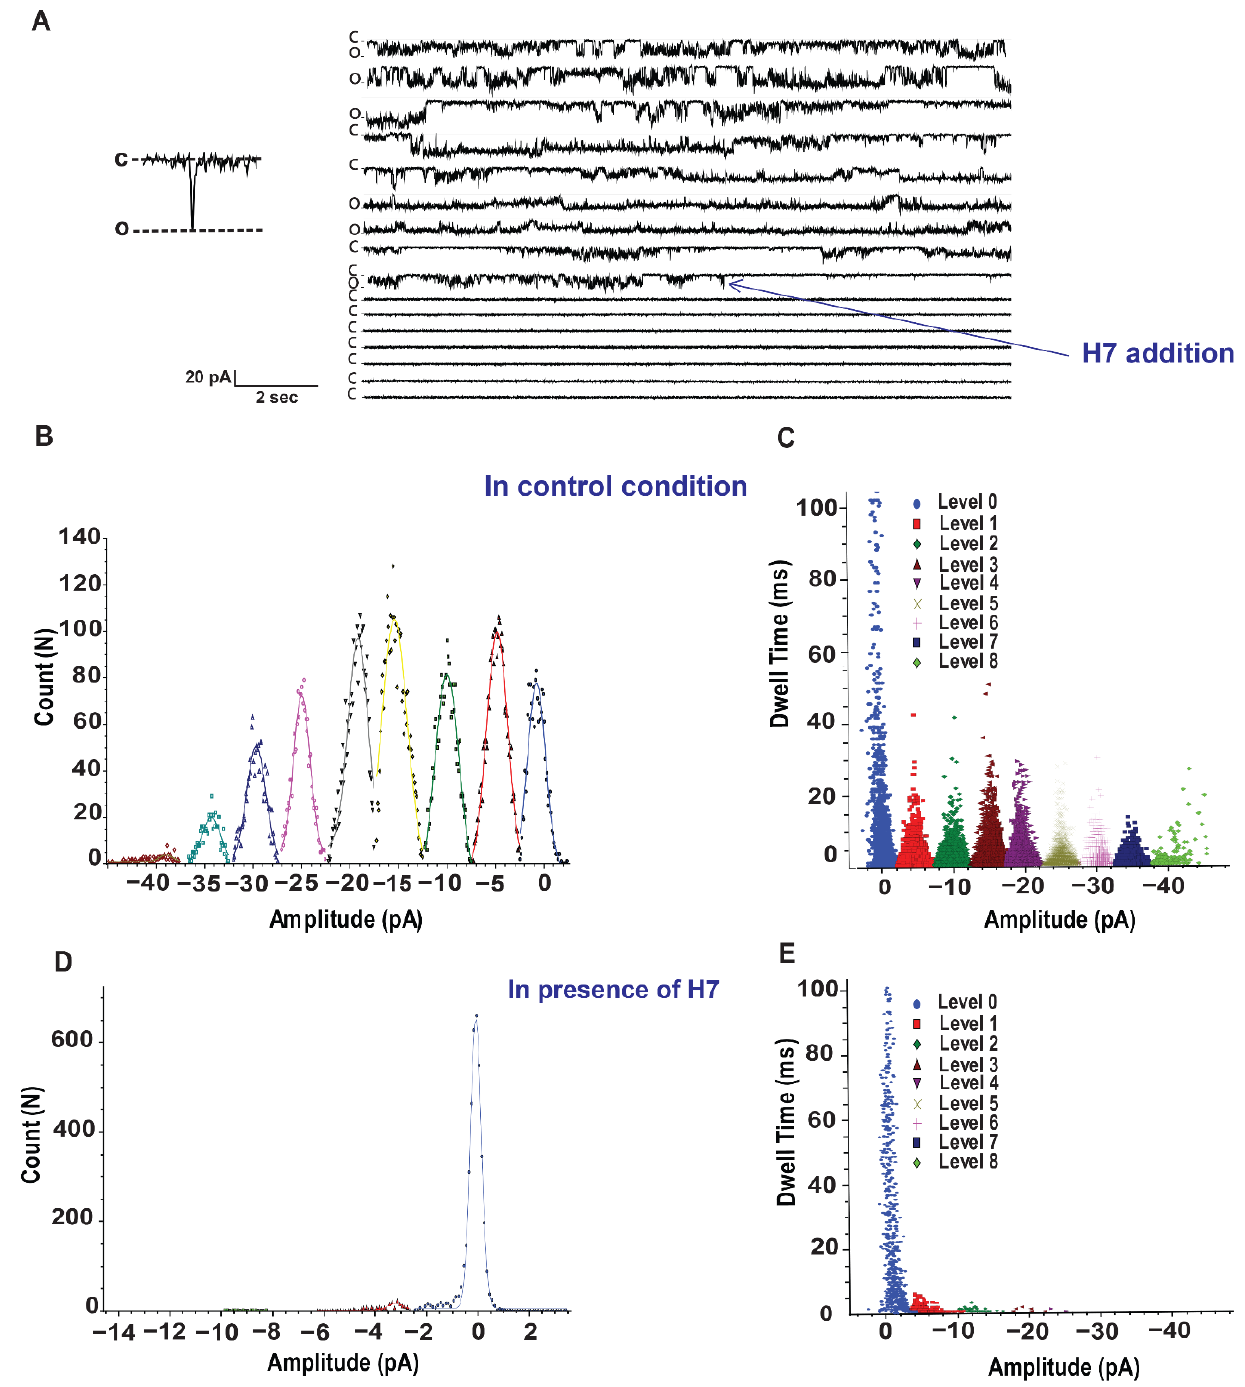
Figure 4. Validation of H7 inhibitory effect on Kv3.1 single current. ( A ) A representative trace of Kv3.1 channels in planar lipid bilayer from 4 min of continuous recording at −60 mV. Closed (c) and open (o) levels are indicated. H7 (0.6 µg/mL) is added at the indicated time point. ( B ) Fits of Gaussian distributions of multiple histograms led to a single channel current level of 4.74 ± 0.063 pA at − 60 mV. ( C ) Dwell time of the whole 4 min recording at − 60 mV revealed channel conductance levels (levels 1 to 8). ( D , E ) represent, respectively multiple histograms and dwell time after addition of